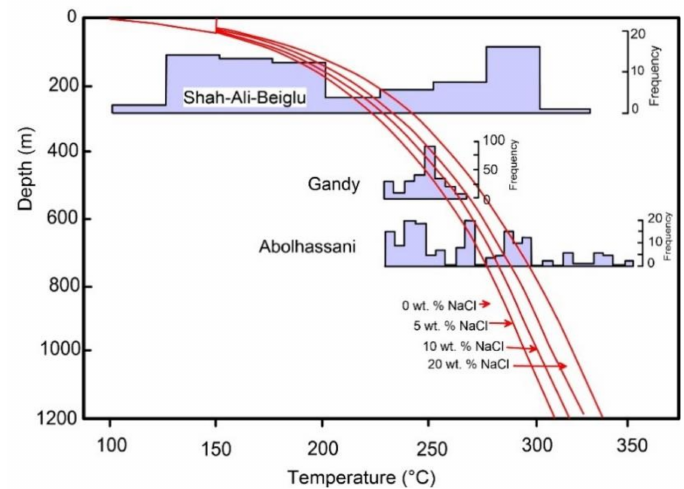
Figure 23. Temperature-depth diagram with boiling-point curves for pure H 2 O (0 wt %) and for brine of different composition given in wt % NaCl (from Haas [100]). Shah-Ali-Beiglou data were fitted at the mean Th values to the 8.6 wt % NaCl curve. Histograms of Gandy and Abolhassani are based on Shamanian et al.